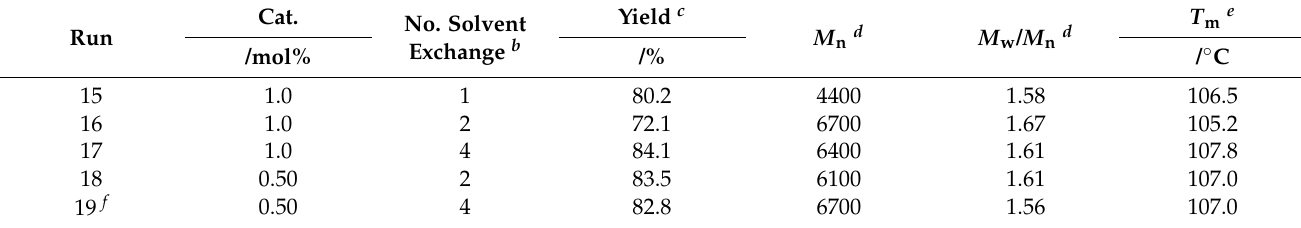
Table 2. ADMET copolymerization of M1 with 1,3-tetradecadiene (TDCD) a . Run Cat.